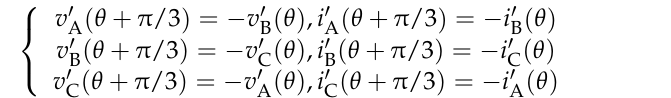
The reference voltage and the output current are three-phase symmetrized.